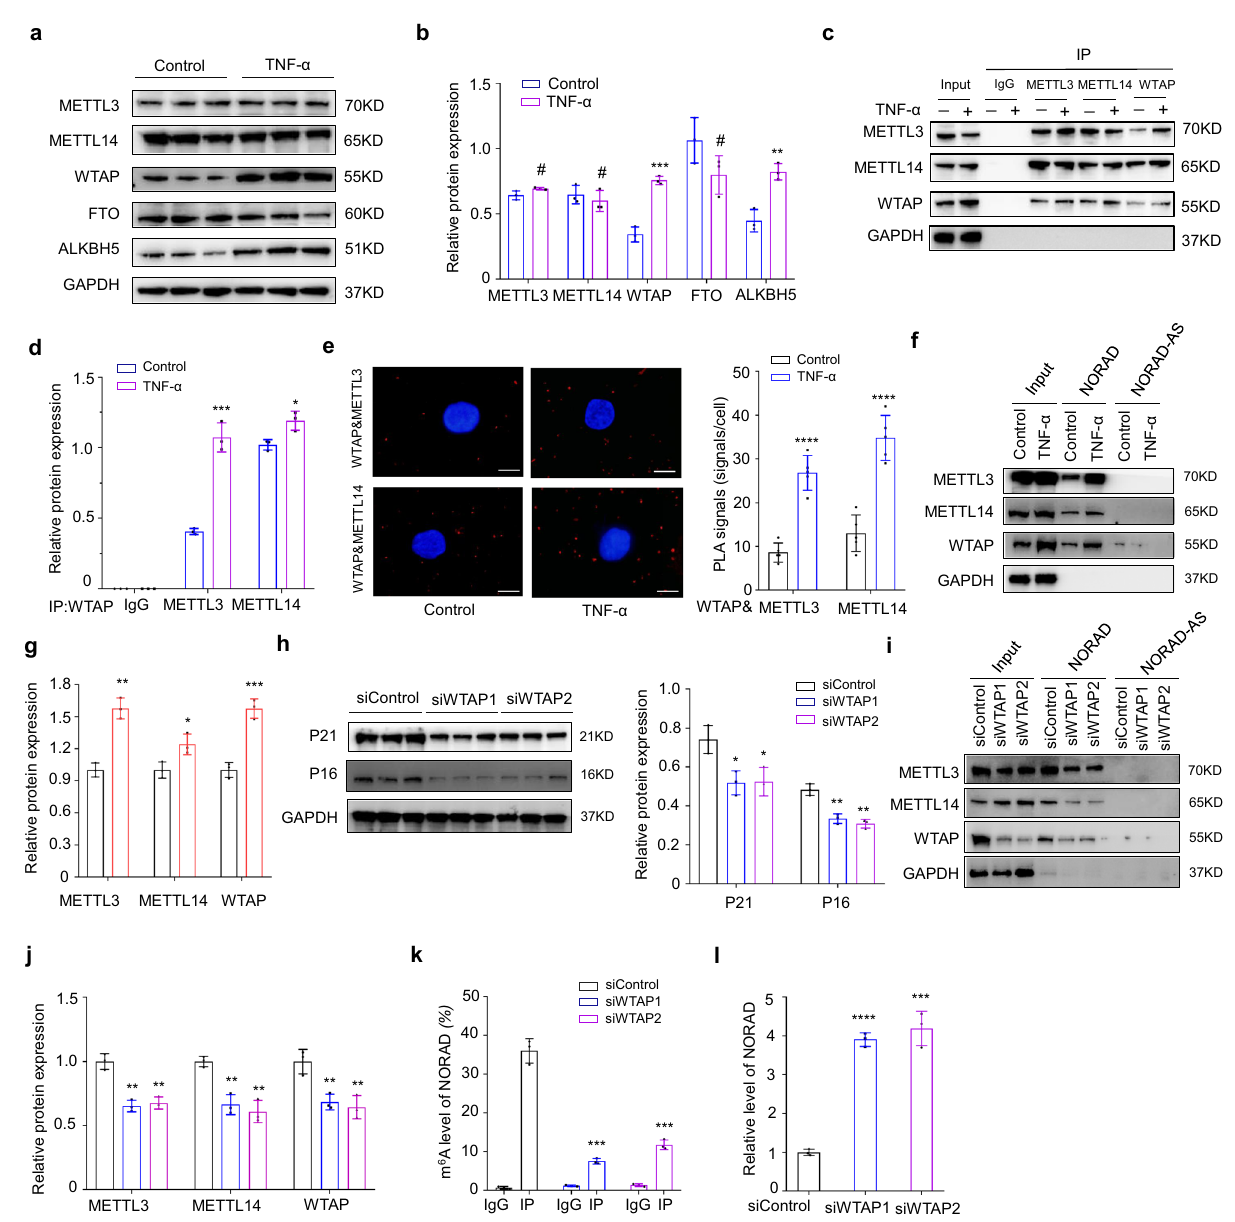
Fig. 3 m 6 A modi fi cation of the lncRNA NORAD contributes to NPC senescence. a , b Protein level of m 6 A METTL3 ( P = 0.0673), METTL14 ( P = 0.4789), WTAP ( P = 0.0004), FTO ( P = 0.1135), and ALKBH5 ( P = 0.0036) in normal and senescent NPCs by western blot, GAPDH was used as the loading control. Data are shown as the mean ± SD, n = 3. # NS, * P < 0.05, *** P < 0.001, two-tailed unpaired Student ’ s t test. c , d Co-IP analysis of the interaction between WTAP and METTL3 ( P = 0.0004), METTL14 ( P = 0.0180). Data are presented as mean ± SD, n = 3. * P < 0.05, *** P < 0.001, two-tailed unpaired Student ’ s t test. e PLAs were used to demonstrate the physical interaction between WTAP and METTL3 ( P < 0.0001) or METTL14 ( P < 0.0001) (red: signal; blue: DAPI; scale bar: 20 μ m). Data are presented as mean ± SD, n = 5, * P < 0.05, **** P < 0.0001, two-tailed unpaired Student ’ s t test. f , g RNA pulldown of NORAD with METTL3 ( P = 0.001), METTL14 ( P = 0.0277), WTAP ( P = 0.0007) in NPCs treated with TNF- α or not. Data are shown as the mean ± SD, n = 3. * P < 0.05, ** P < 0.01,*** P < 0.001, two-tailed unpaired Student ’ s t test. h Protein level of P21 ( P = 0.0252; 0.0219) and P16 ( P = 0.0027; 0.0012) in TNF- α -treated NPCs by western blot with WTAP silencing or not, GAPDH was used as the loading control. Data are shown as the mean ± SD from three independent experiments. * P < 0.05, ** P < 0.01, two-tailed unpaired Student ’ s t test. i , j RNA-pulldown of NORAD with METTL3 ( P = 0.0027; 0.0022), METTL14 ( P = 0.0084; 0.0094), WTAP ( P = 0.0014; 0.0020) in NPCs with WTAP silencing or not, followed by western blot. Data are shown as the mean ± SD, n = 3. ** P < 0.01, two-tailed unpaired Student ’ s t test. k Me-RIP-qPCR analysis of the m 6 A level of NORAD transcripts ( P = 0.0001; 0.0002) in NPCs with or without WTAP silencing. Data are shown as the mean ± SD from three independent experiments. *** P < 0.001,